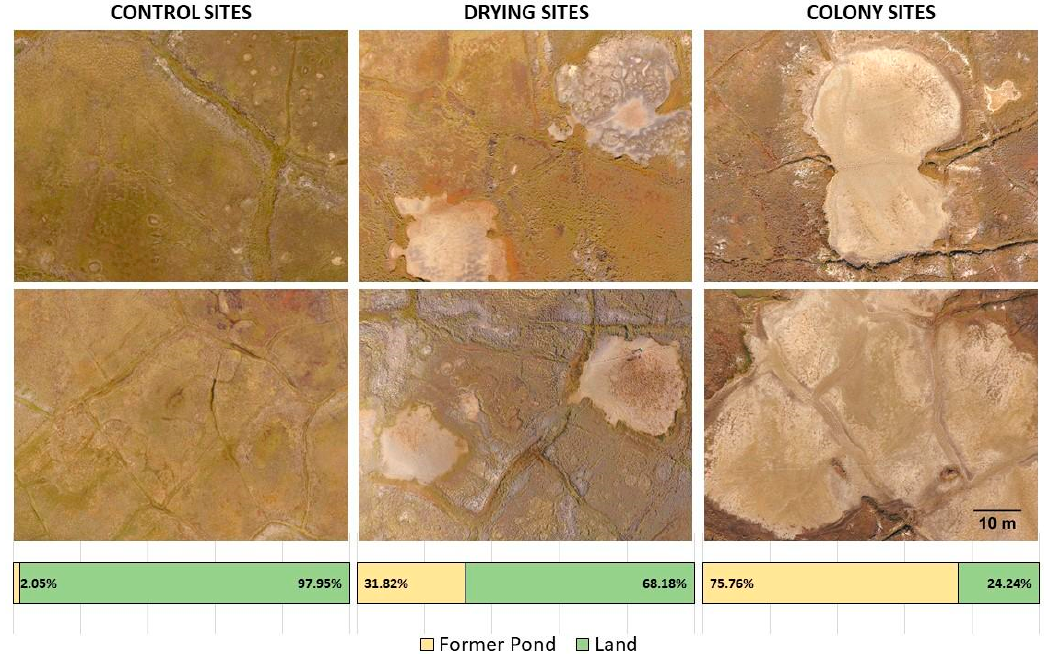
Figure 7. Aerial photographs captured using an unmanned aerial vehicle (UAV) during July 2017 field surveys. The bars below the images show the proportion of field transects classified as former pond basins and regular land.